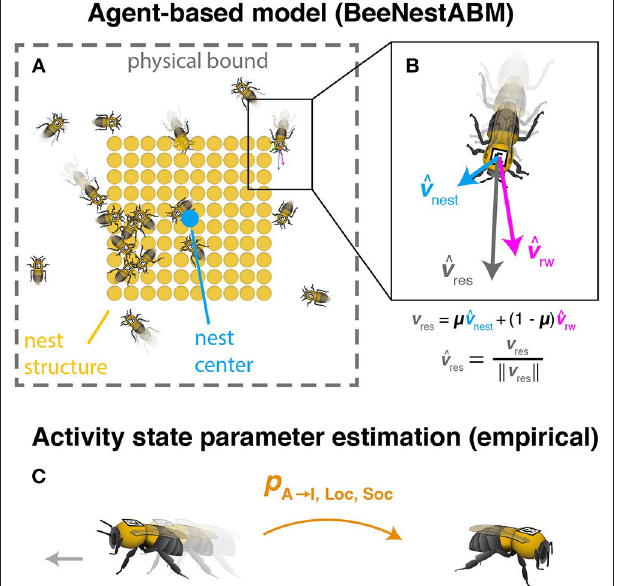
FIGURE 1 | estimates for untreated bees, middle values (in parentheses) show the percent change in the estimated parameters in bees fed 1.0 ng imidacloprid (compared to controls), and lower values are p -values. Bold values indicate significant effects, with box color indicating the direction of change (red for decreasing, green for increasing). Figure adapted from Figure S4 and data from Figure S5 in Crall et al.